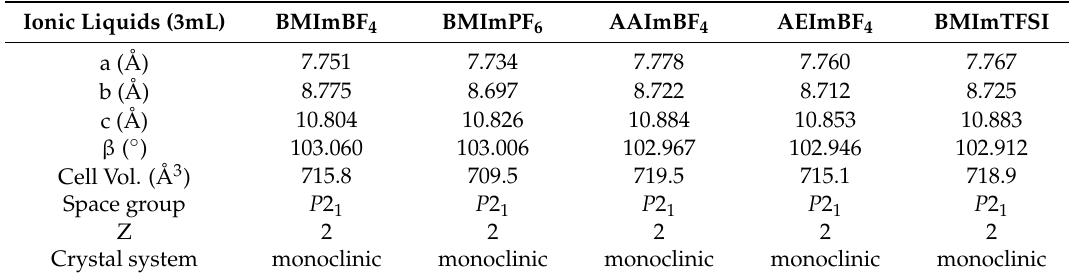
Table 1. Single-crystal X-ray diffraction (SXD) data of sucrose crystals isolated from A. gigas.